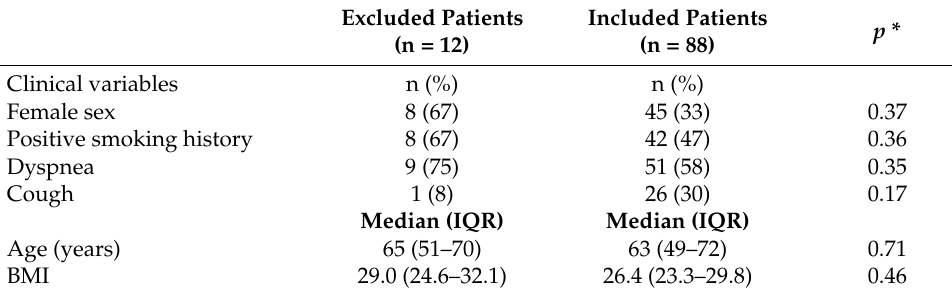
Table A1. Comparison of the excluded and included